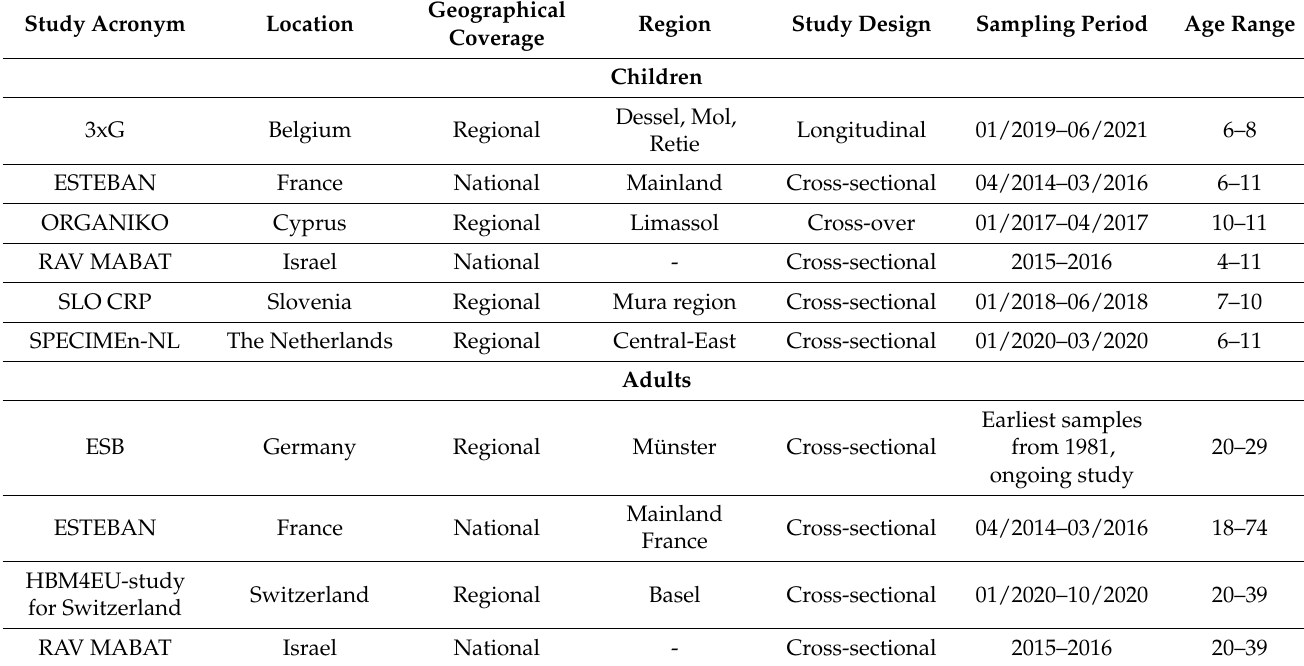
Table 1. Summary description of the characteristics of the HBM4EU-aligned studies used for this risk assessment. More information on the cohorts can be found in Govarts et al.